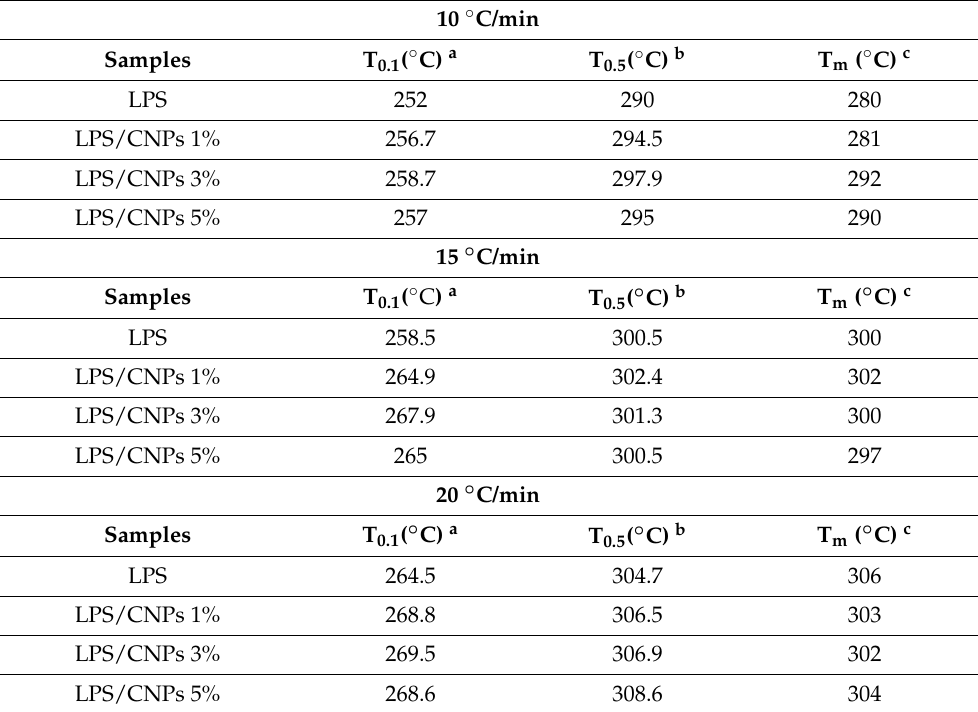
Table 3. Thermal properties data of LPS and LPS/CNPs nanocomposites. 10 °C/min